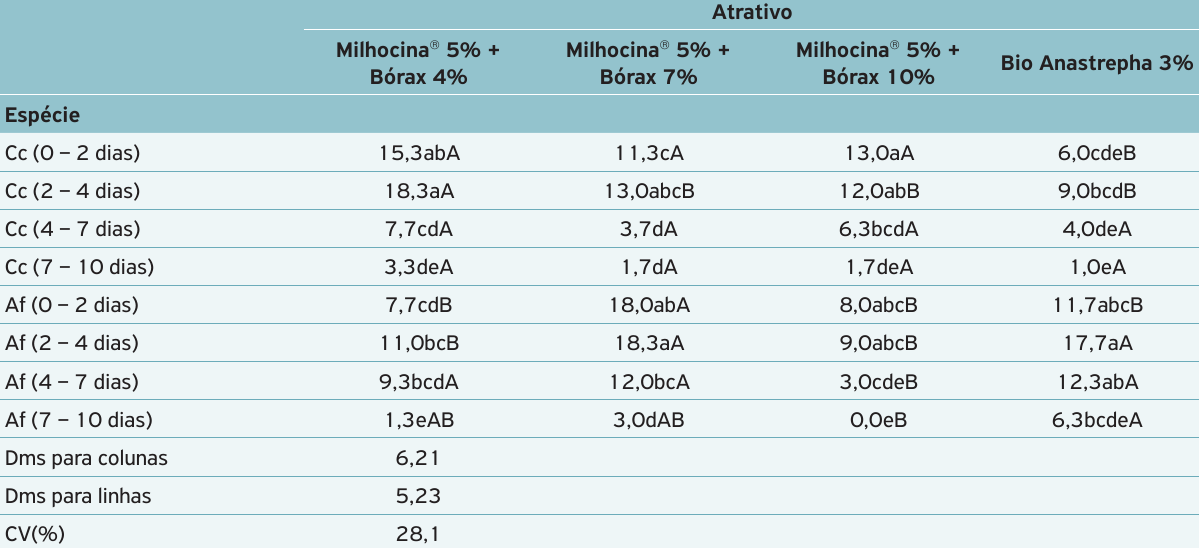
Tabela 3. Valores médios de machos de Ceratitis capitata e de Anastrepha fraterculus capturados por armadilhas McPhail contendo diferentes atrativos alimentares, mantidas em gaiolões de campo durante quatro idades dos atrativos. Campinas, São Paulo, janeiro a fevereiro,